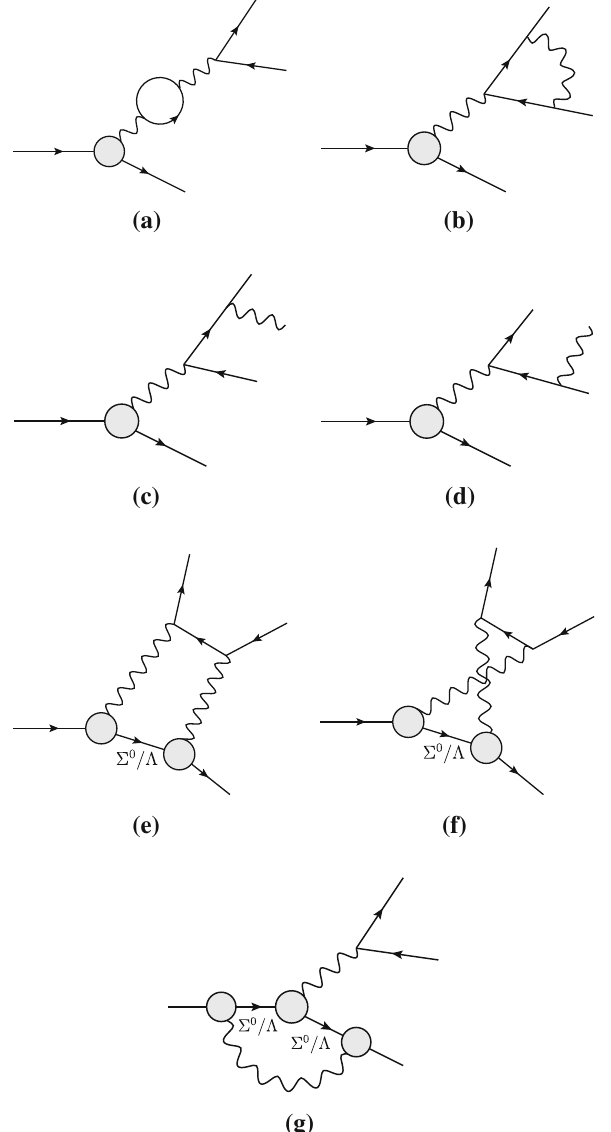
Fig. 2 NLOQEDradiativecorrectionsforthedecay Σ 0 → Λ e + e − : a lepton-loopvacuum-polarizationinsertion, b correctiontotheQEDver- tex, c , d bremsstrahlung, e , f one-loop one-photon-irreducible (1 γ IR) contributions, g Σ 0 Λγ vertex correction. In the 1 γ IR contribution each diagram comes in two variants: with Σ 0 or Λ exchanged. Similarly, there are four diagrams contributing to the transition-form-factor cor- rection ( g